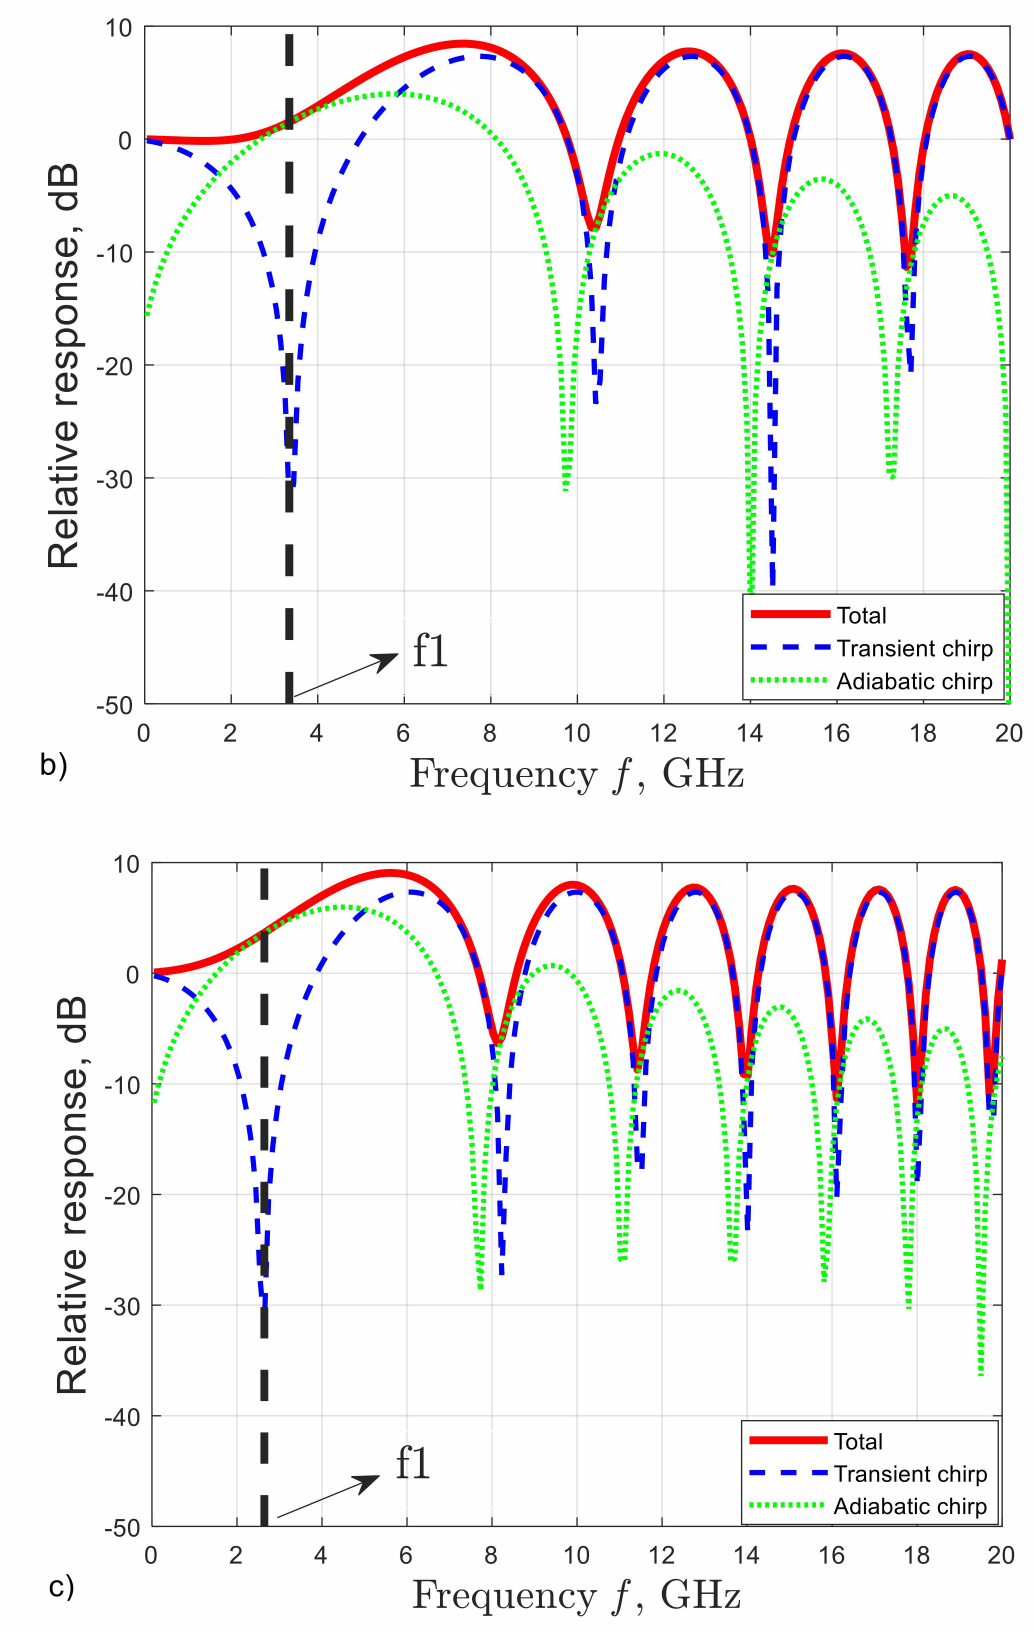
Figure 4. Decomposition of frequency response (transient chirp and adiabatic chirp) of SMFs with different fiber lengths L. ( a ) L = 25 km, ( b ) L = 75 km, and ( c ) L = 118